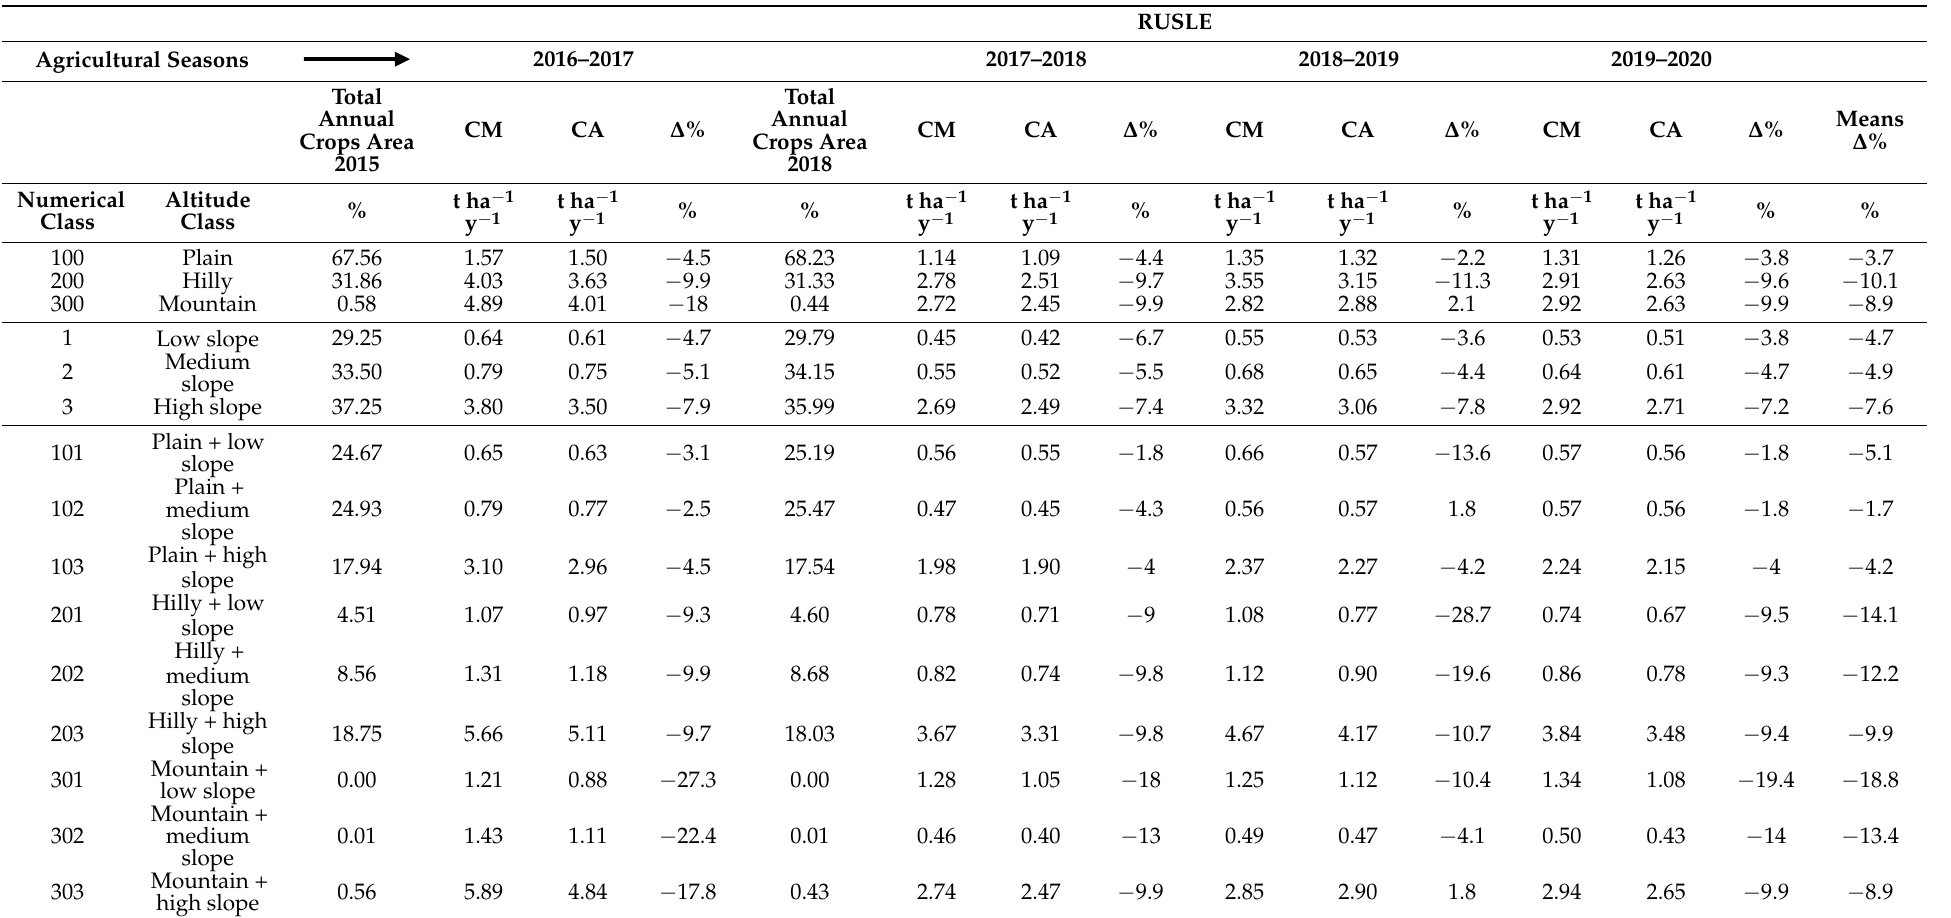
Table 3. RUSLE calculation for each altitude and slope class and their combination of the two management systems in four years in the Apulia region. CM = conventional management. CA = conservation agriculture. RUSLE = Revised Universal Soil Loss Equation. ∆ % = percentage difference.